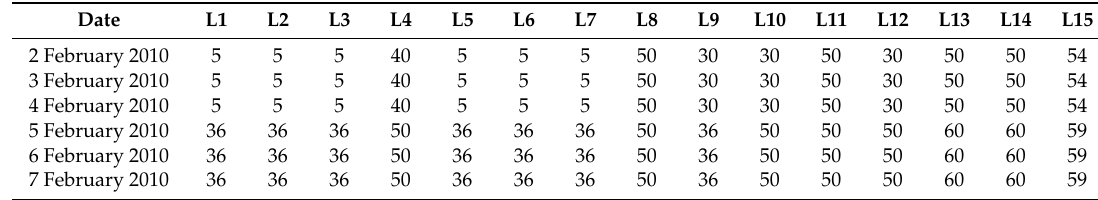
Table 3. Extract of H eq _ max values